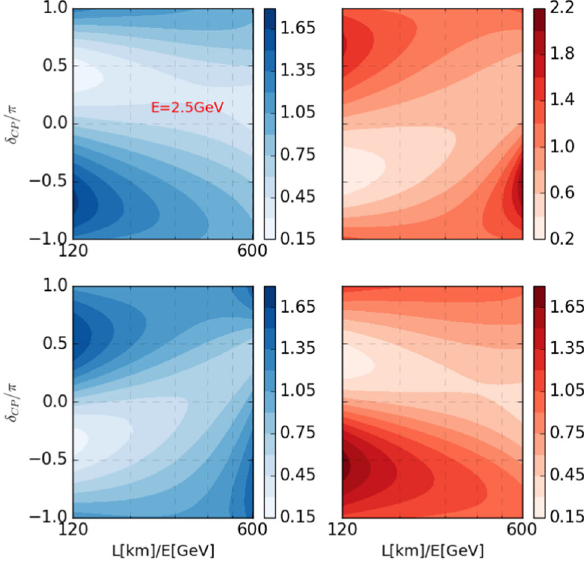
Fig. 7 Same as Fig. 5 but the reference energy E = 2 . 5 GeV has been fixed to the DUNE flux peak energy. For this peak energy and DUNE baseline, L / E = 520